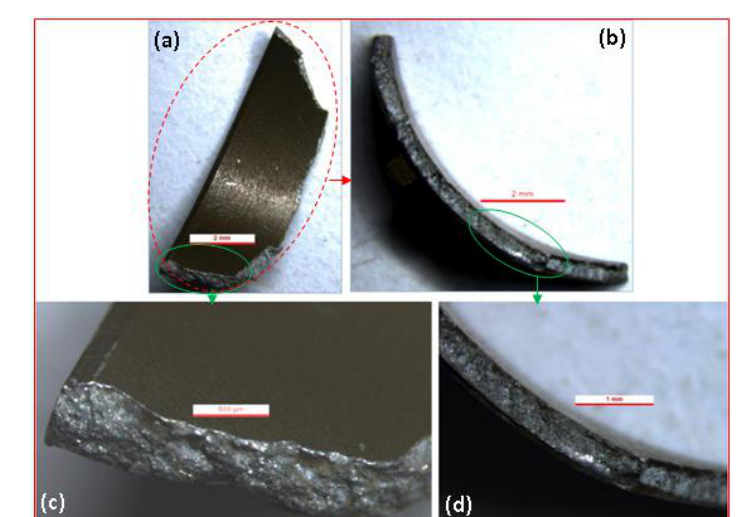
Figure 5: Photographs of the as-received connector 2 in different views